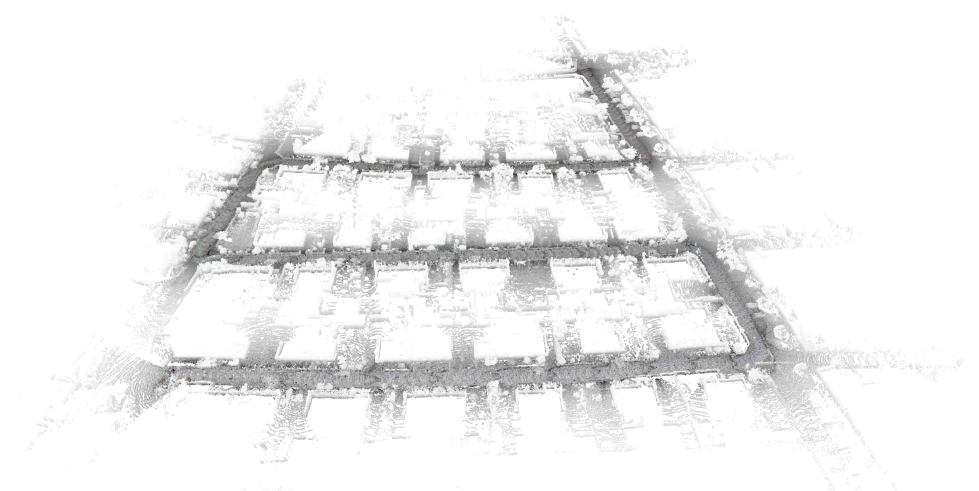
Figure 5. The high-precision maps of KITTI datasets.